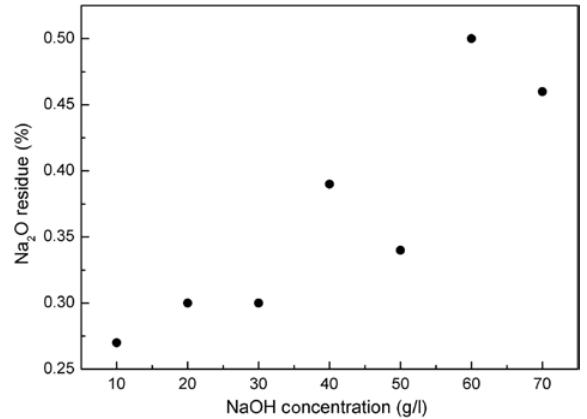
Figure 4: X-ray diffractogram of carbonated residues produced from the discrete and direct processes; X-ray diffractogram of raw red mud.